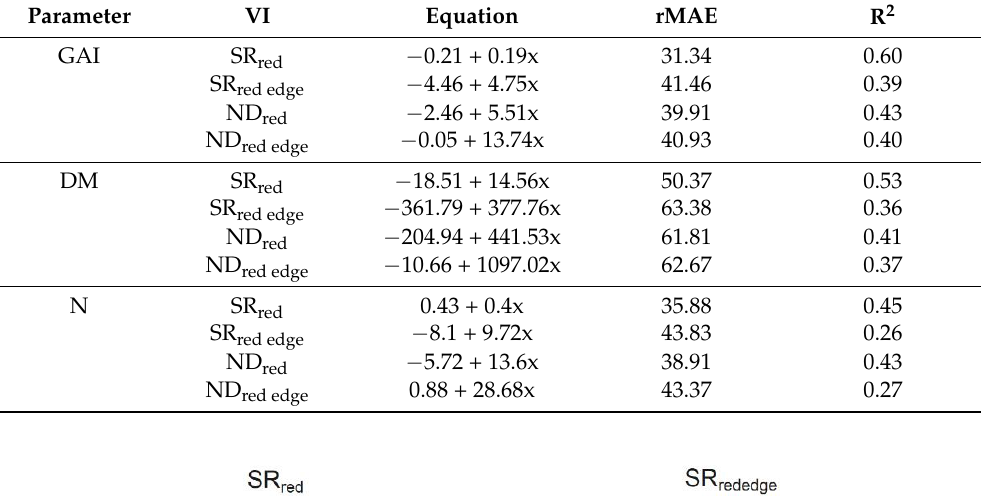
Table 4. Universal models for predicting canopy parameters (green area index (GAI), dry matter